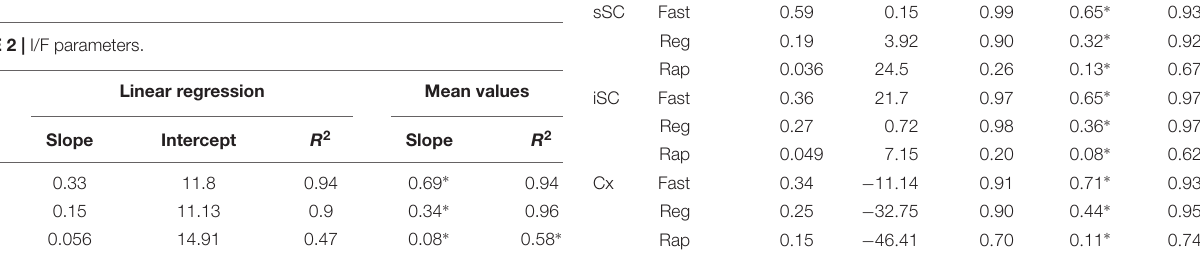
TABLE 3 | I/F parameters. Linear regression Mean values